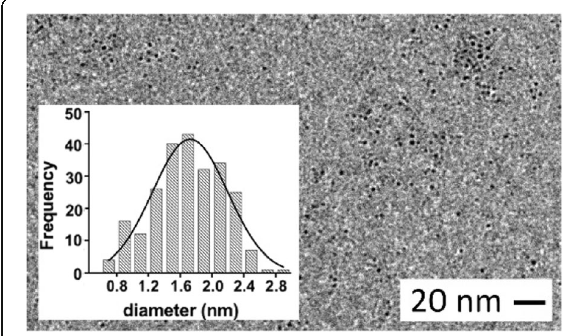
Fig. 4 TEM image of G0-OVA-AuNCs (3/4). Insert: size distribution of gold core diameter of G0-OVA-AuNCs